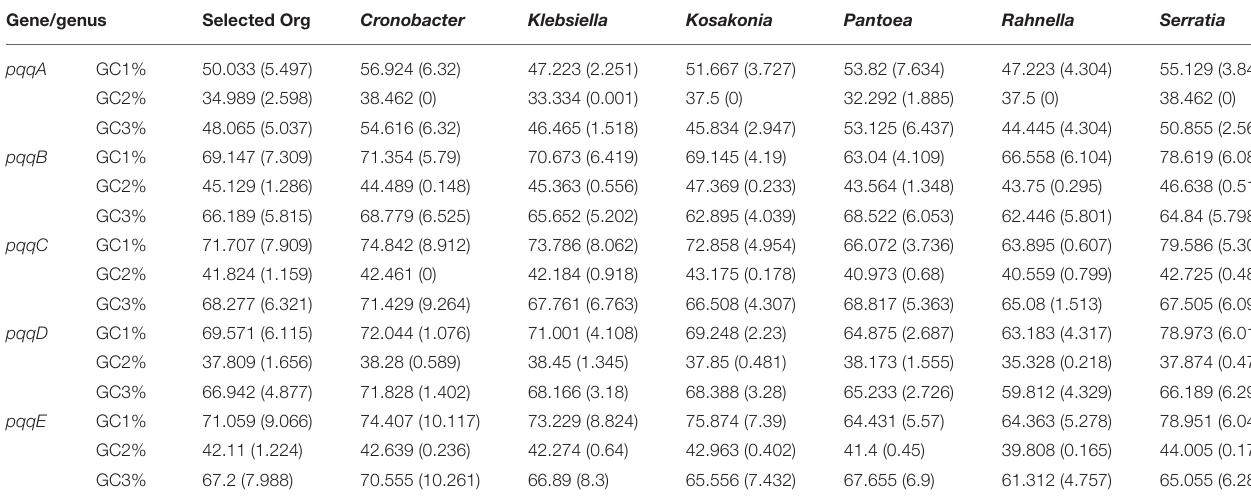
TABLE 2 | Average and standard deviation of different positional GC%s (GC1%, GC2%, and GC3%) values of the pqqA – pqqE genes involved in the PQQ biosynthesis pathway from Cronobacter , Klebsiella , Kosakonia , Pantoea , Rahnella, and Serratia .